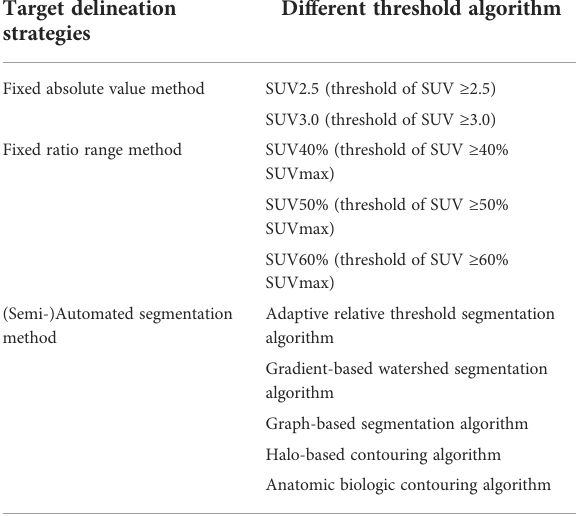
TABLE 3 Different parameters of PET/CT for target volume delineation in NPC. Target